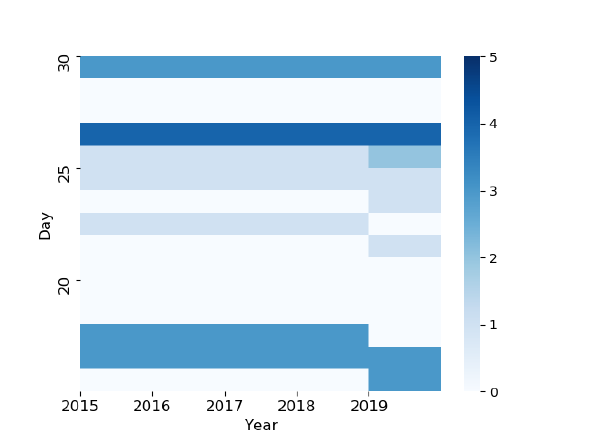
Figure 19: Clustering output for O 3 for last 15 days in Q 3 over 2015 to 2019.